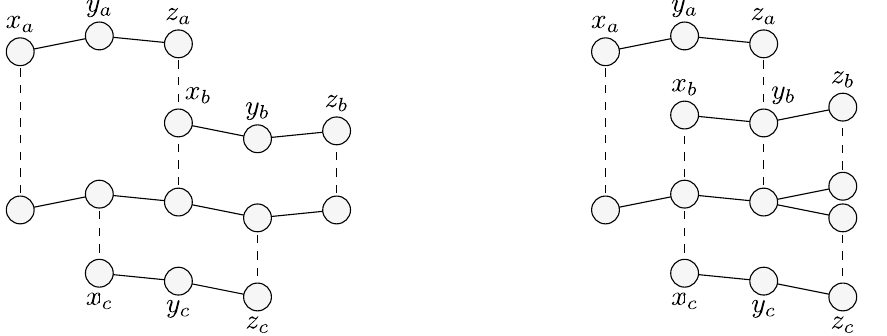
Figure 6. Two examples of structures resulting by “gluing together” a set of overlapping (α , ε) -aligned triples.